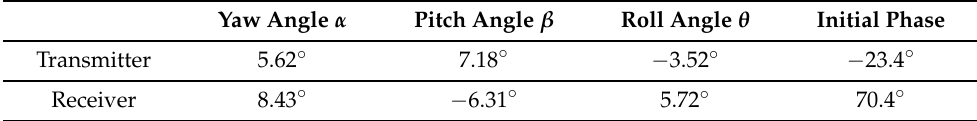
Table 6. The error information obtained from the INS in the mini-UAV-based BiSAR